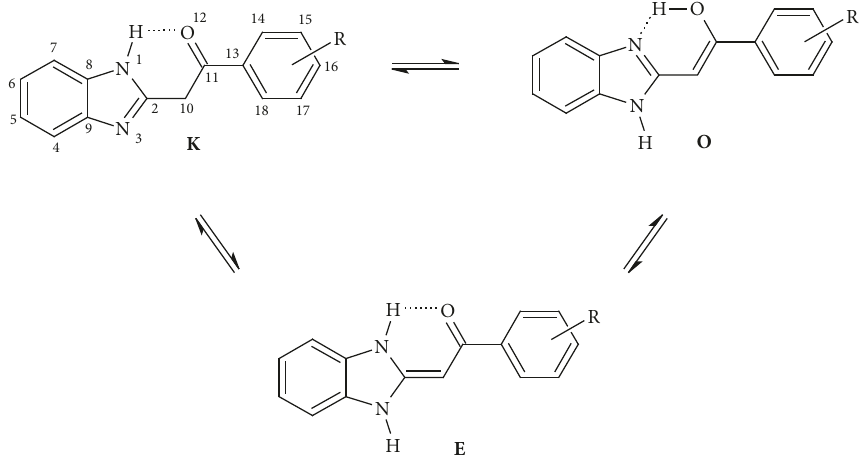
Table 1: Selected 1 H and 13 C NMR chemical shifts for 2-phenacylbenzimidazoles [2-(1 H -benzo[ d ]imidazol-2-yl)-1-phenylethan-1-ones] K and ( Z )-2-(1 H -benzo[ d ]imidazol-2-yl)-1-phenylethen-1-ol O (solutions in DMSO- d (𝑖𝑡𝑎𝑙𝑖𝑐𝑠) a .